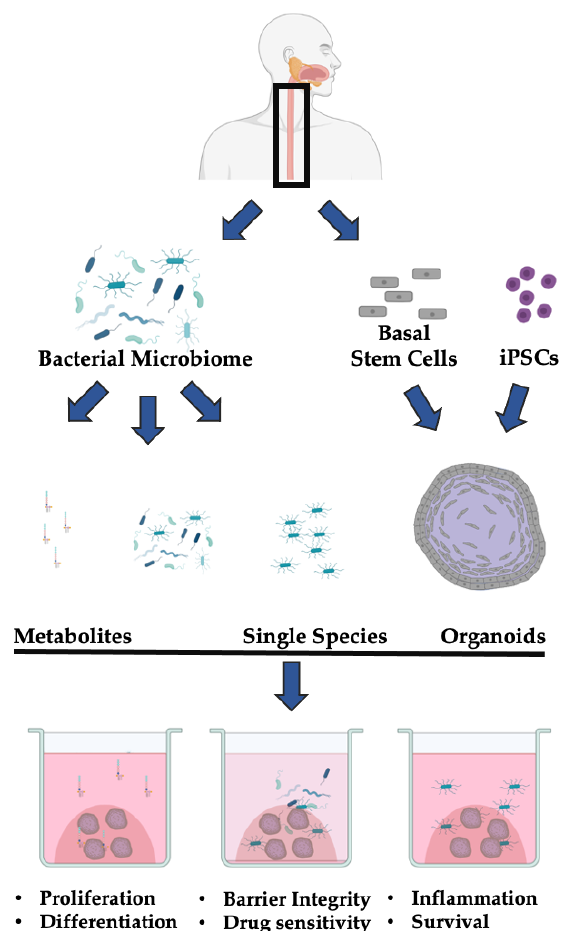
Figure 1. Leveraging 3D organoids to study host–microbiome interactions in esophageal cancers. Patient-derived esophageal tissue can be dissociated into single cells and used to generate organoids. In parallel, the host bacterial microbiome can be isolated and specific bacteria species or products can be cultured or purified, respectively. These cultures or products can then be combined with patient-derived organoids. The ascribed endpoints can be used to assess the effect of the microbiome on the salient biological features of the esophageal stratified epithelium. Created with BioRender.com (accessed on 10/15/2021).